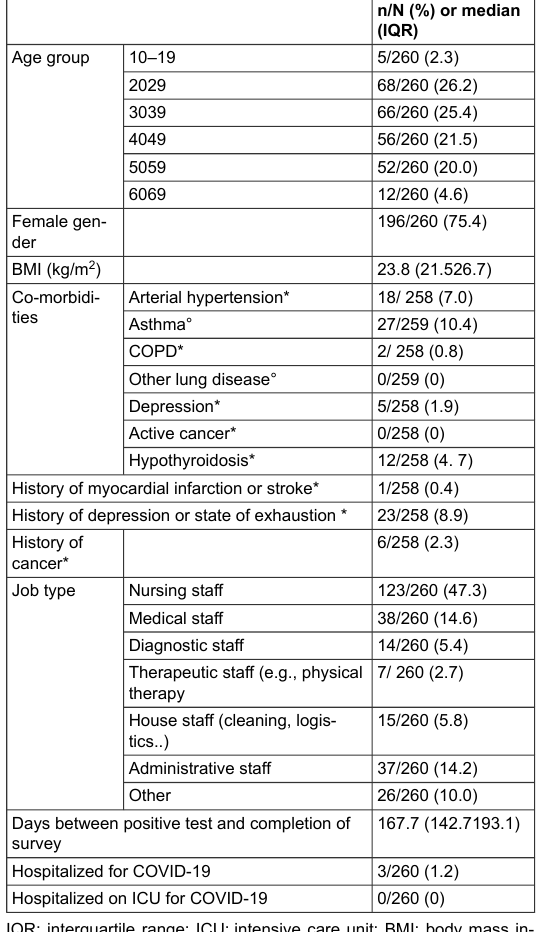
Table 1: Baseline characteristics of the patients with SARS-CoV-2 infection ≥90 days